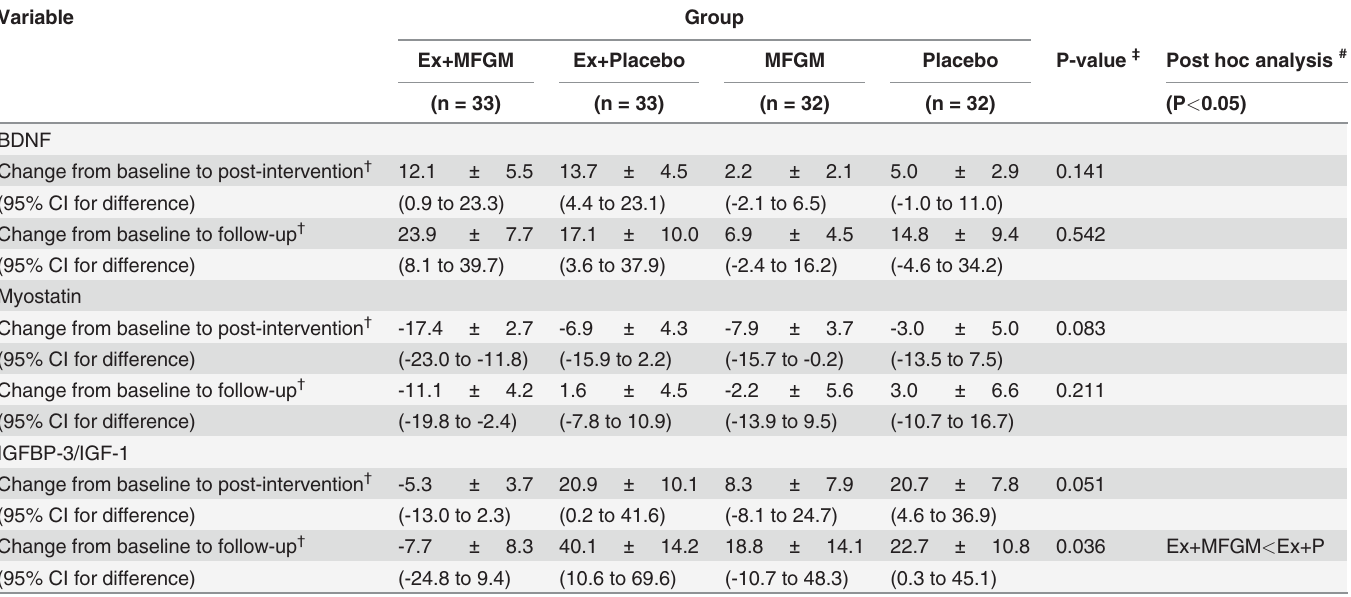
Table 5. Effects of the intervention on blood components between baseline, post-intervention and